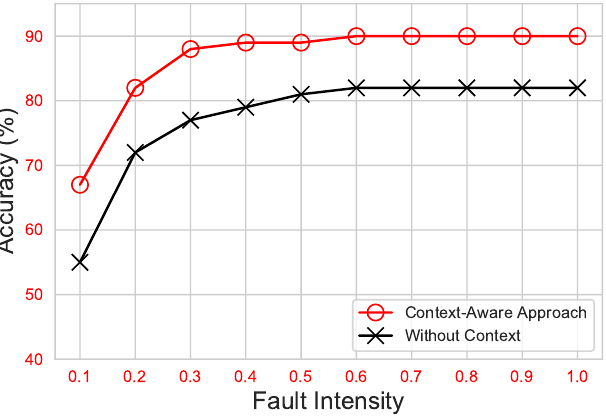
Figure 10. Diagnostic accuracy of the context-aware approach vs. the without-context (traditional) approach for ET on diverse fault